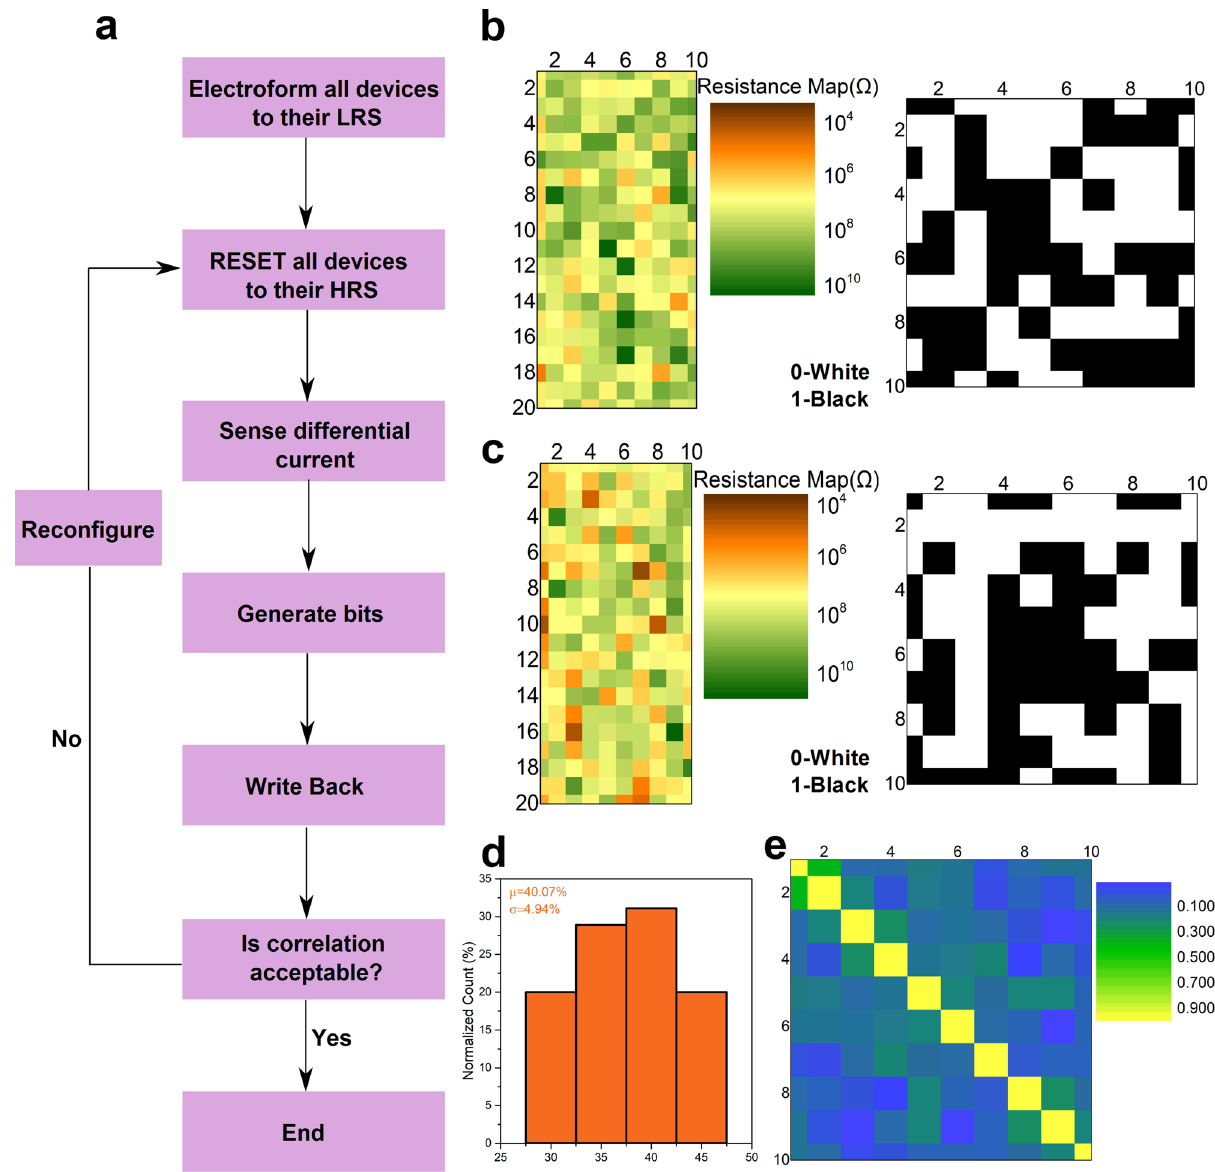
Fig. 4 Recon fi gurable halide perovskite (HP) memristor physical unclonable functions (memPUFs). a Recon fi guration fl owchart showing how recon fi guration is done exploiting cycle-to-cycle variability by resetting to HRS and running through the same protocol again every cycle to generate fresh keys. The PUF is repeatedly recon fi gured as long as the correlation factor between the new key and the key from the previous cycle is not low enough. b , c Analog color map and digitized checkerboard before and after one cycle of recon fi guration showing the bits are different after recon fi guration. d 10 cycles of consecutive writes are (cid:1) (cid:3) 10 ¼ 45 pairs of bit-streams, with a mean value of 40.06% showing done for recon fi guration. Histogram of recon fi guration HD obtained by calculating HD of 2 good independence of the key bits across cycles. e Correlation matrix for 10 cycles of recon fi guration showing an average correlation of